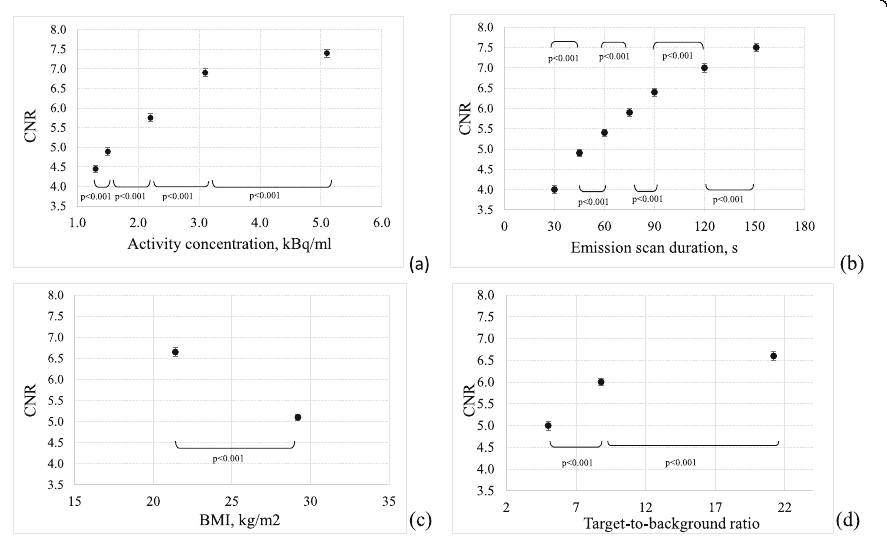
Fig. 4 CNR as a function of AC ( a ), ESD ( b ), W ( c ) and TBR ( d ). Points represent least square averages; vertical bars represent 95% confidence intervals. The results of the Scheffè test are displayed for the adjacent levels of the predictor